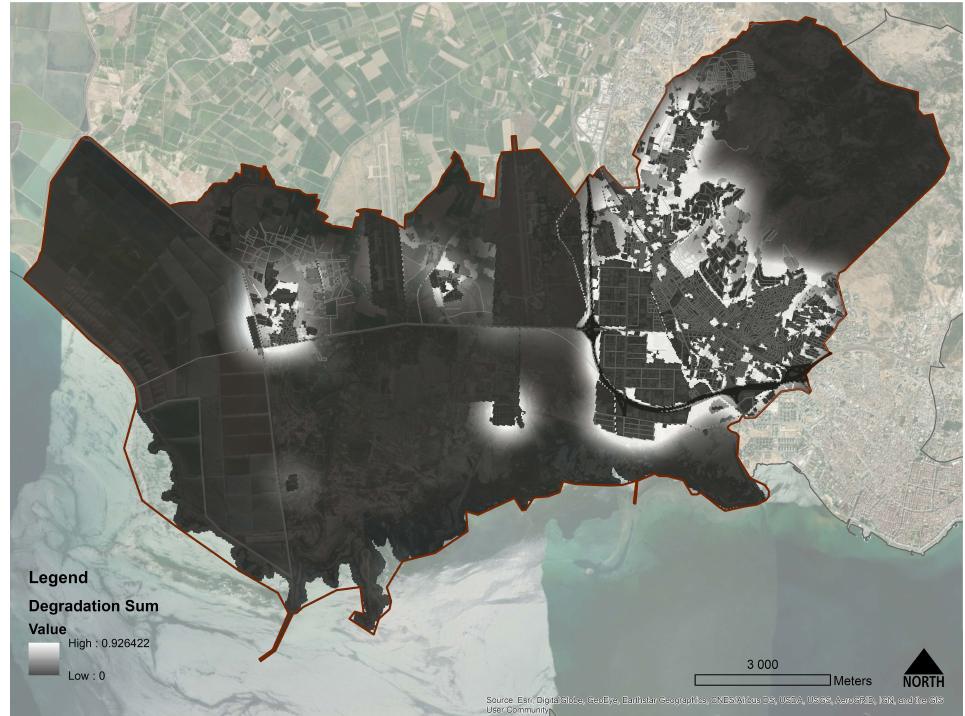
Figure 6. Habitat Quality values of Çi ğ li district (source: author’s elaboration).